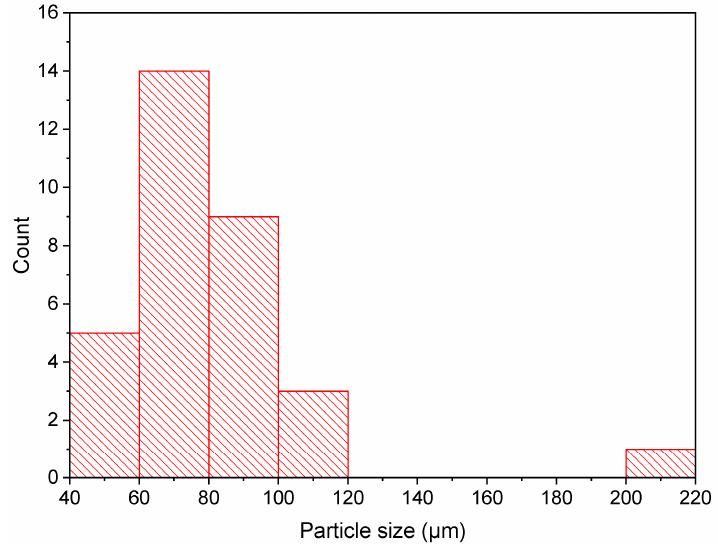
Figure 15. Particle size distribution.